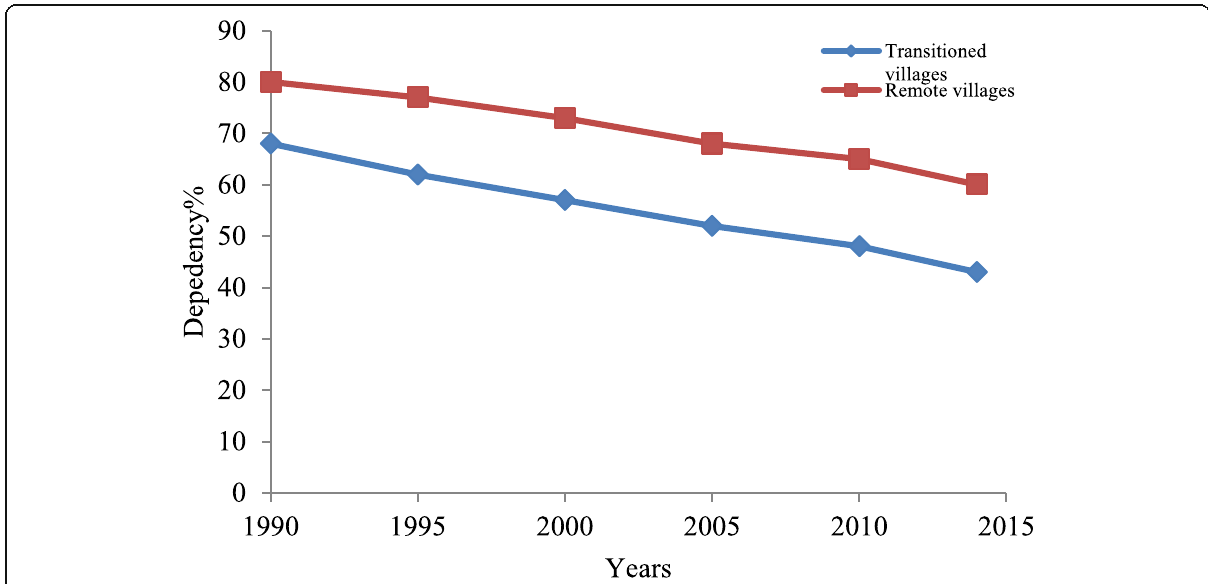
Fig. 4 Dependency percentage of Adi on forest-based traditional foods over the year near town and in remote